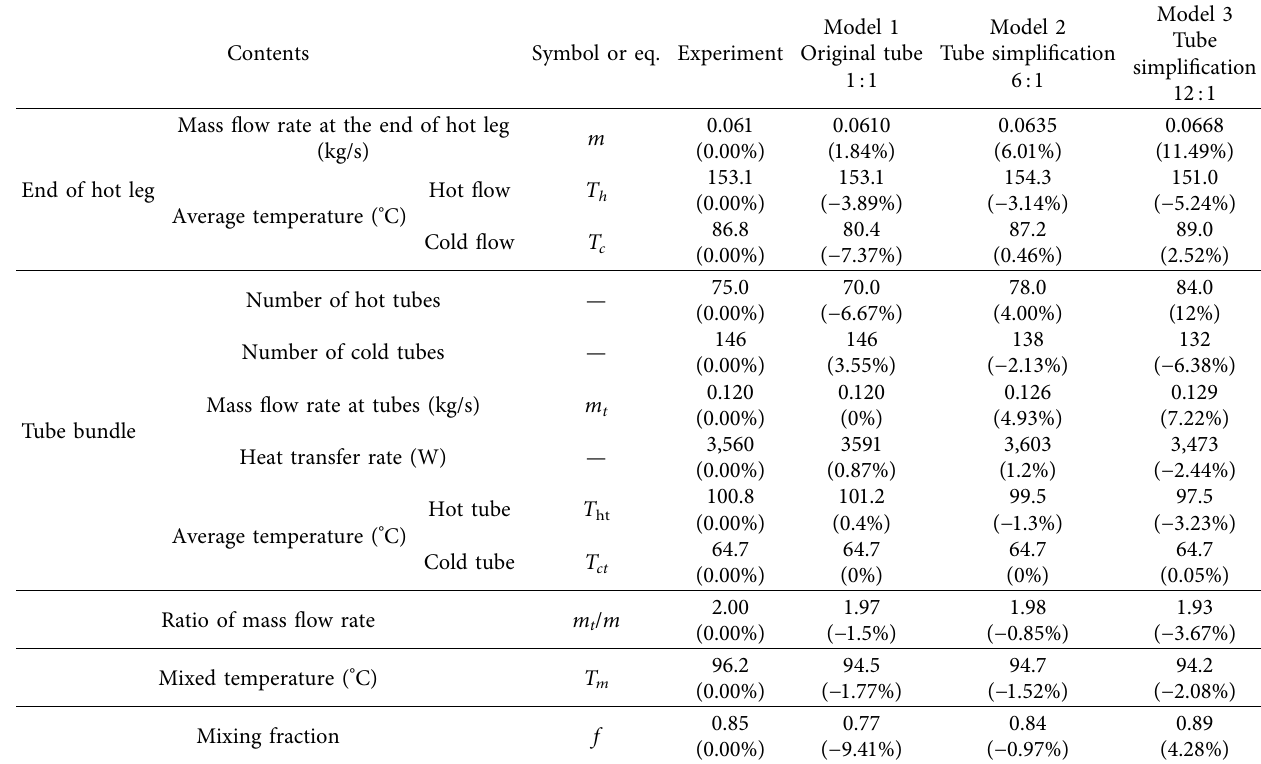
Table 3: Comparison of the main evaluation factors for each